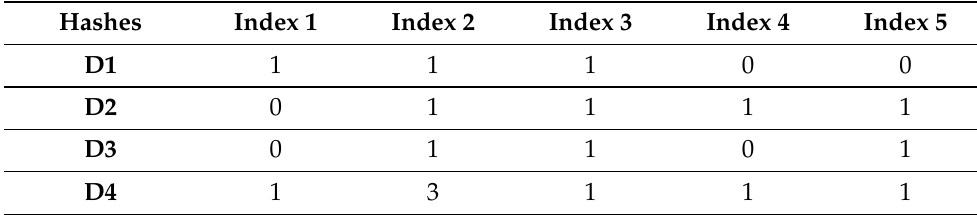
Table 8. Vector representation of the sample corpus shown in Table 4 using the feature hashing model. Unlike the other models, only 5 columns are observed for representing the documents, which corresponds to the number of indexes in the hash